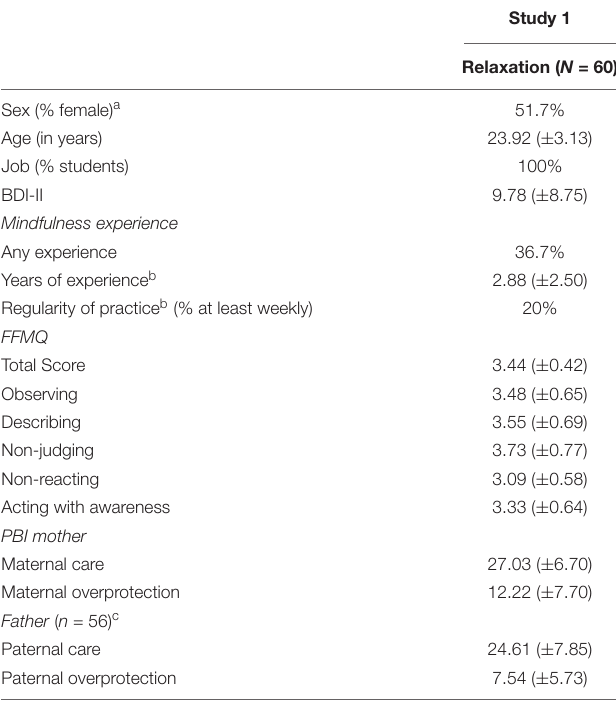
TABLE 1 | Sample characteristics in Study 1.